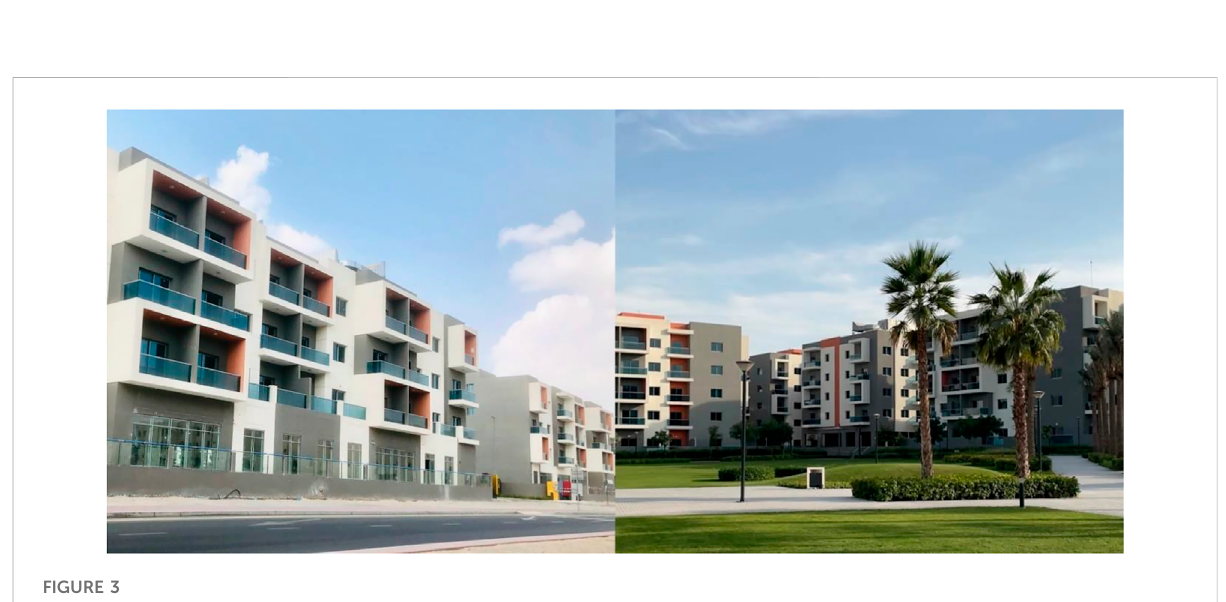
FIGURE 3 Wasl green park labor camp at ras Al khor industrial